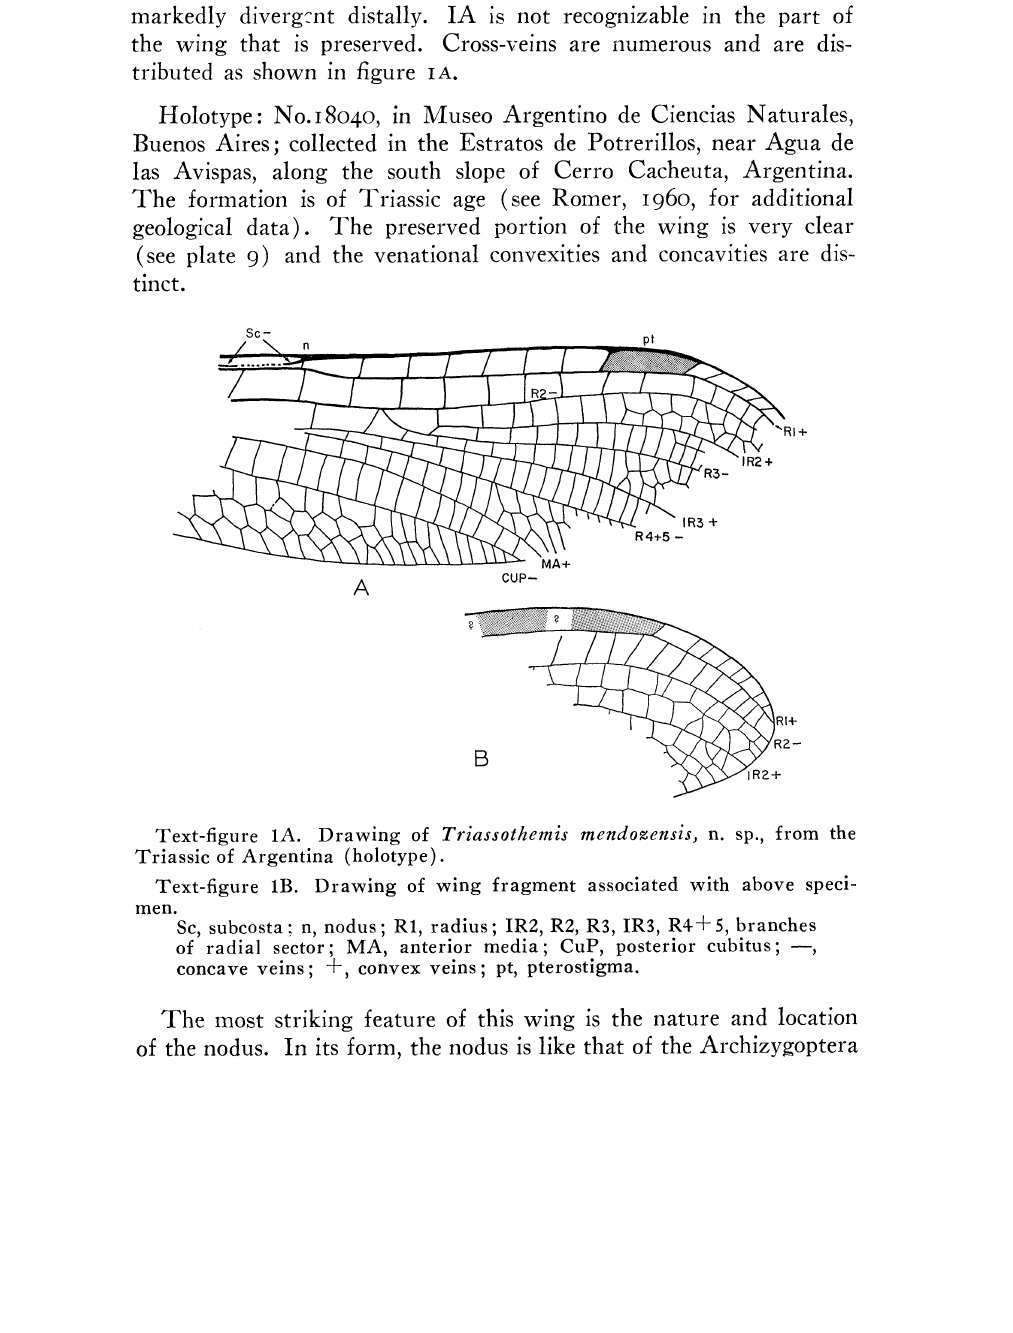
Text-figure 1A. Drawing of Triassothemis mendozensis, n. sp., from the Triassic of Argentina (holotype). Text-figure lB. Drawing of wing fragment associated with above speci-